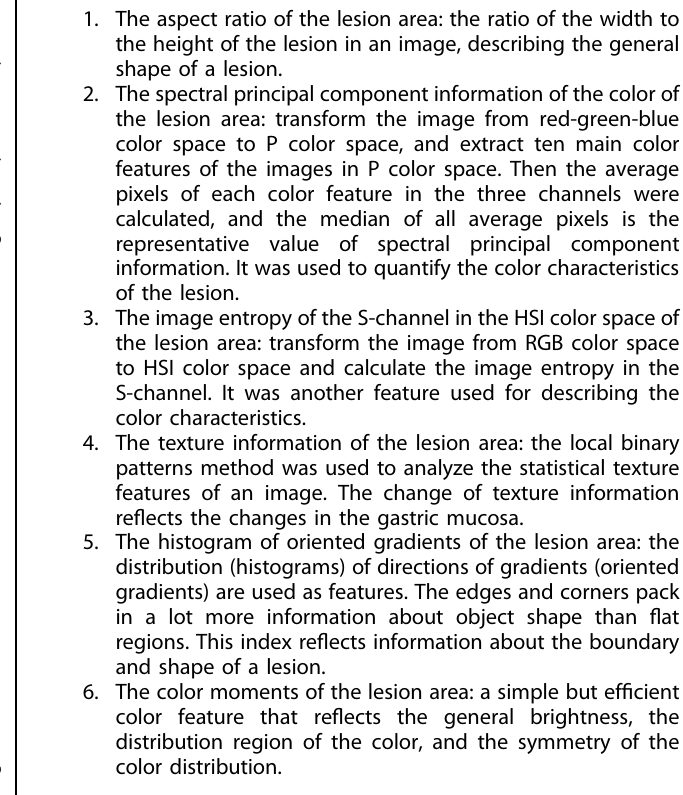
detect focal lesions with a sensitivity of 96.90%. The seventh feature-extraction model was previously developed a lesion was further classi fi ed into three categories, the upper- middle stomach, the lower stomach, and undistinguishable. The quantitative features were extracted and analyzed based on the localized area by YOLO-v3. These quantitative features included: 1. The aspect ratio of the lesion area: the ratio of the width to the height of the lesion in an image, describing the general shape of a lesion. 2. The spectral principal component information of the color of the lesion area: transform the image from red-green-blue color space to P color space, and extract ten main color features of the images in P color space. Then the average pixels of each color feature in the three channels were calculated, and the median of all average pixels is the representative value of spectral principal component information. It was used to quantify the color characteristics of the lesion. 3. The image entropy of the S-channel in the HSI color space of the lesion area: transform the image from RGB color space to HSI color space and calculate the image entropy in the S-channel. It was another feature used for describing the color characteristics. 4. The texture information of the lesion area: the local binary patterns method was used to analyze the statistical texture features of an image. The change of texture information re fl ects the changes in the gastric mucosa. 5. The histogram of oriented gradients of the lesion area: the distribution (histograms) of directions of gradients (oriented gradients) are used as features. The edges and corners pack in a lot more information about object shape than fl at regions. This index re fl ects information about the boundary and shape of a lesion. 6. The color moments of the lesion area: a simple but ef fi cient color feature that re fl ects the general brightness, the distribution region of the color, and the symmetry of the color